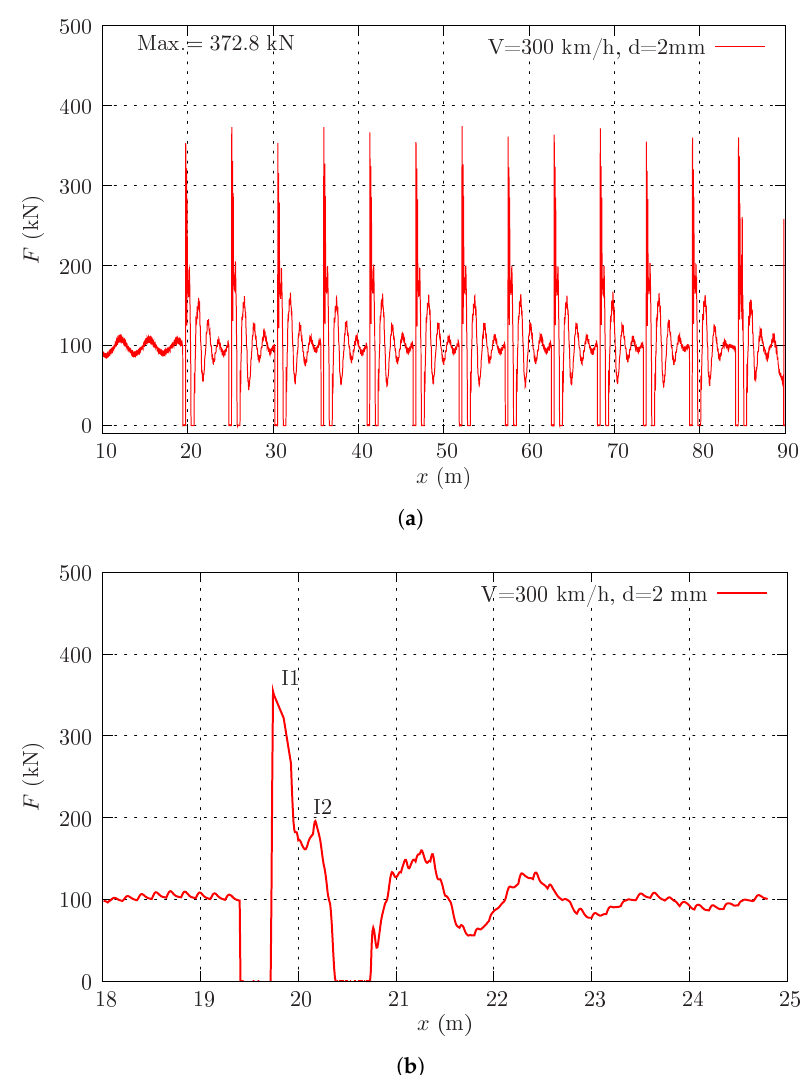
Figure 6. Variation of the dynamic load along the ballasted track due to a wheel flat running at 300 km/h ( d = 2 mm). ( a ) Along the track; ( b ) detail.